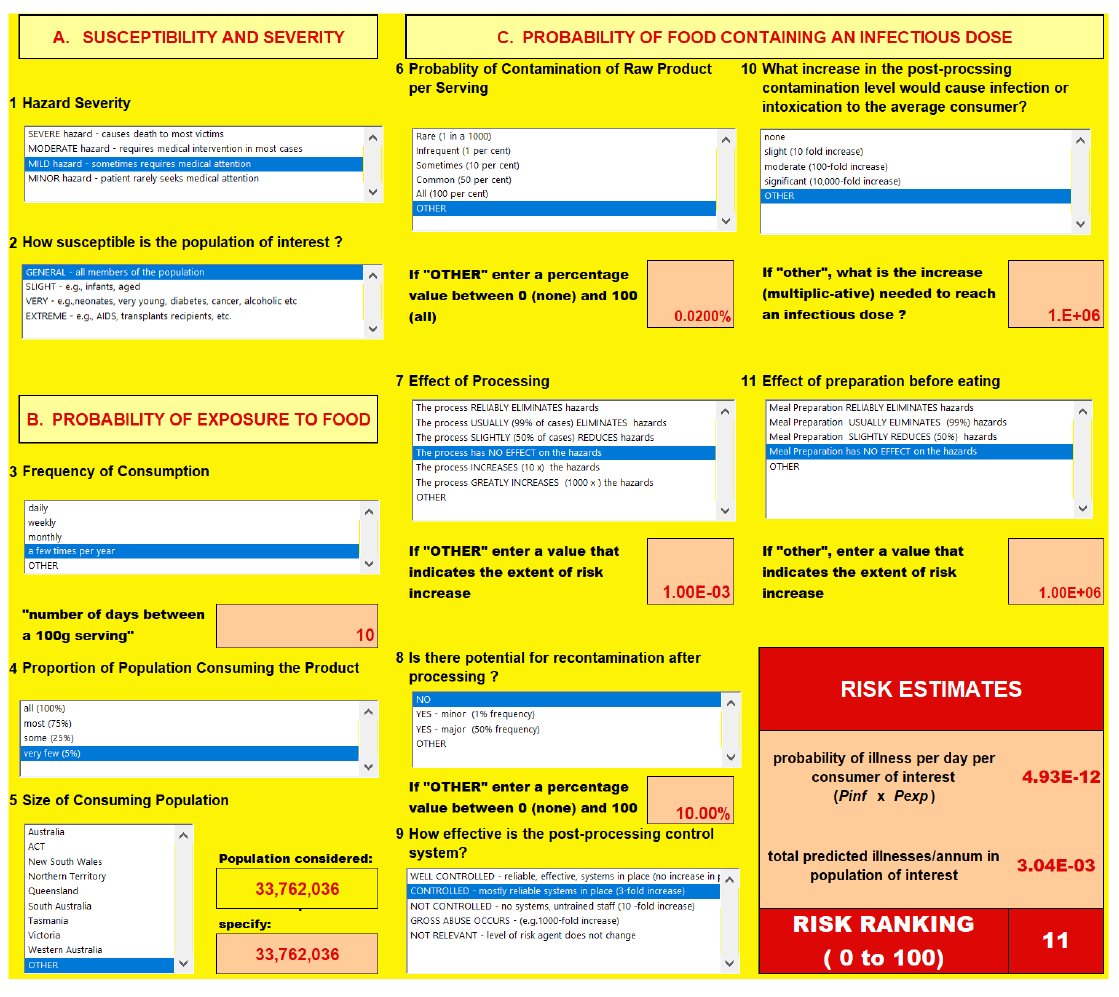
Figure 3. Screenshot for frozen